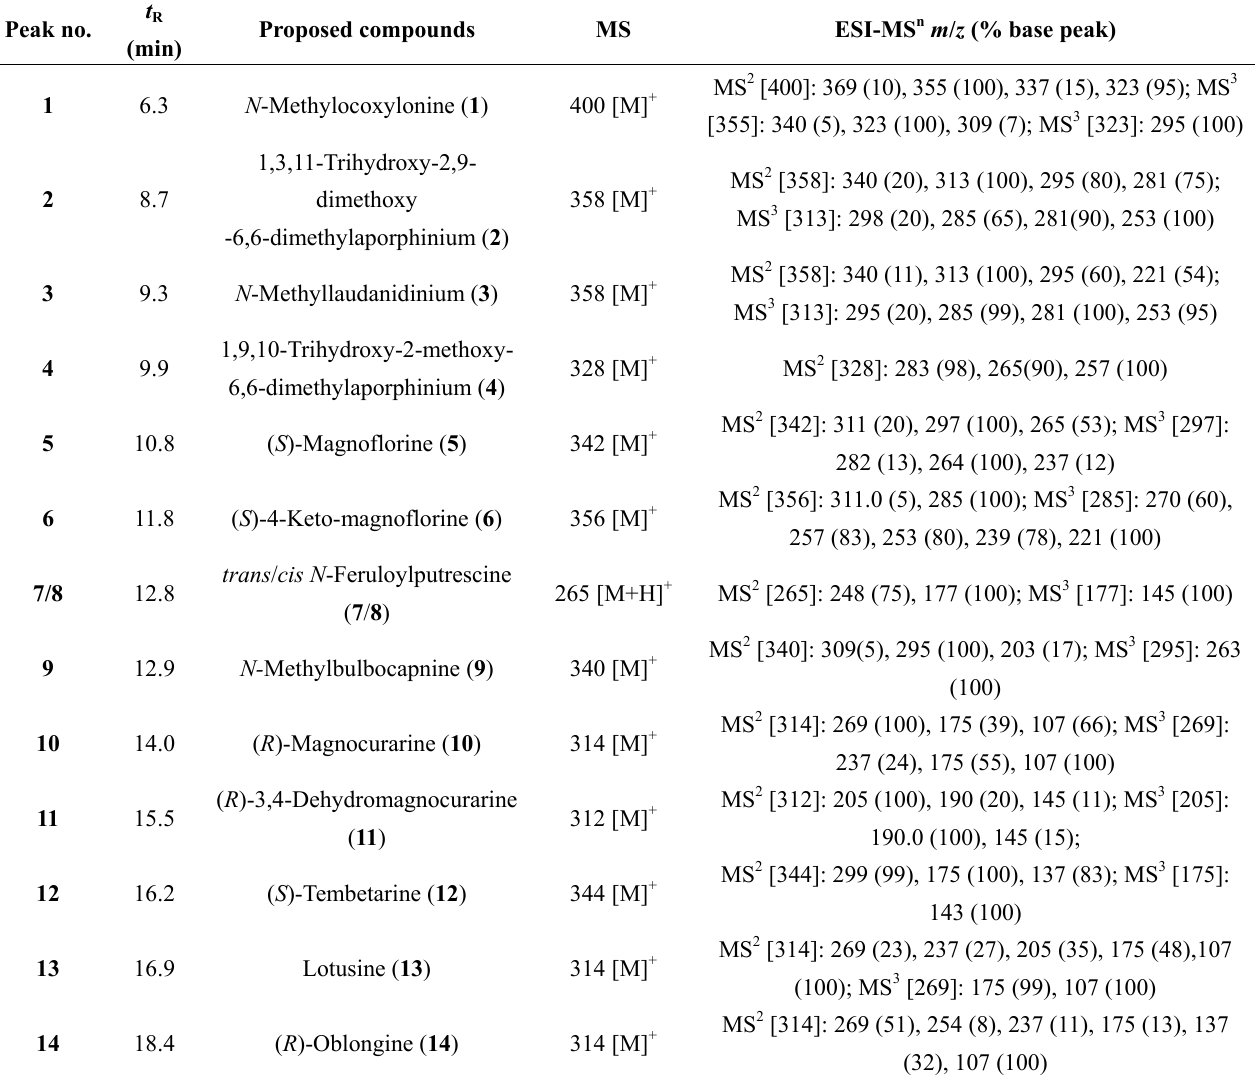
Table 1. Retention time and MS data of alkaloids in stem bark of M . officinalis. Peak